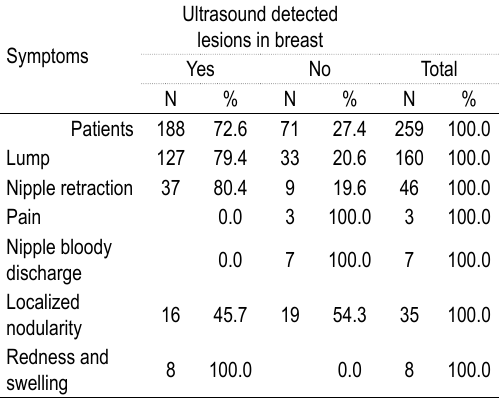
Table 6. Sensitivity of ultrasound in breast cancer diagnosis according to symptoms